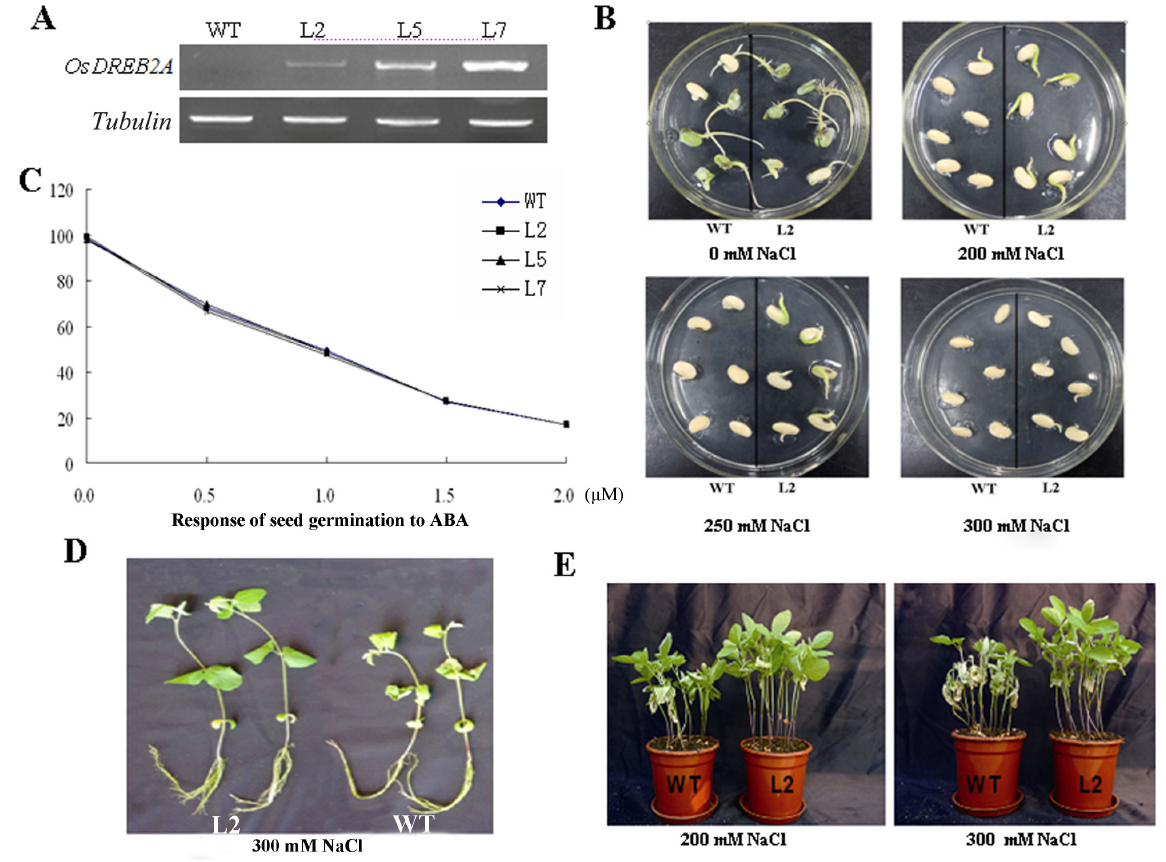
Figure 1. Response to salt stress of OsDREB2A overexpressing in plants. (A) OsDREB2A overexpression in soybean. Transcripts of OsDREB2A in transgenic lines (L2, L5, L7) were detected using RT-PCR, WT were used as control. Tubulin was used as an internal control and added 1 m g in 20 ul RT- PCR system. (B) Salt tolerances of germination assay. Eighteen seeds from the WT and transgenic lines were germinated on MS agar medium containing different concentrations of NaCl. The representative pictures were taken on the 7 th day. (C) Response of seed germination to ABA. Seeds on 1/2 MS solid medium with different concentrations of ABA were incubated at 25 u C for 3 d and scored. (D) For hydroponic culture experiment, the taproot, lateral root and fibrous root were assayed between transgenic soybean (L2) and WT at 48 h after treatment with 300 mM NaCl, respectively. (E) Representative images of transgenic lines grown in soil under salt conditions. Four-week-old plants growing in soil irrigated with 200 mM NaCl and 300 mM NaCl three times a week for two consecutive weeks, respectively. The photographs were taken 14 d after salt treatment.